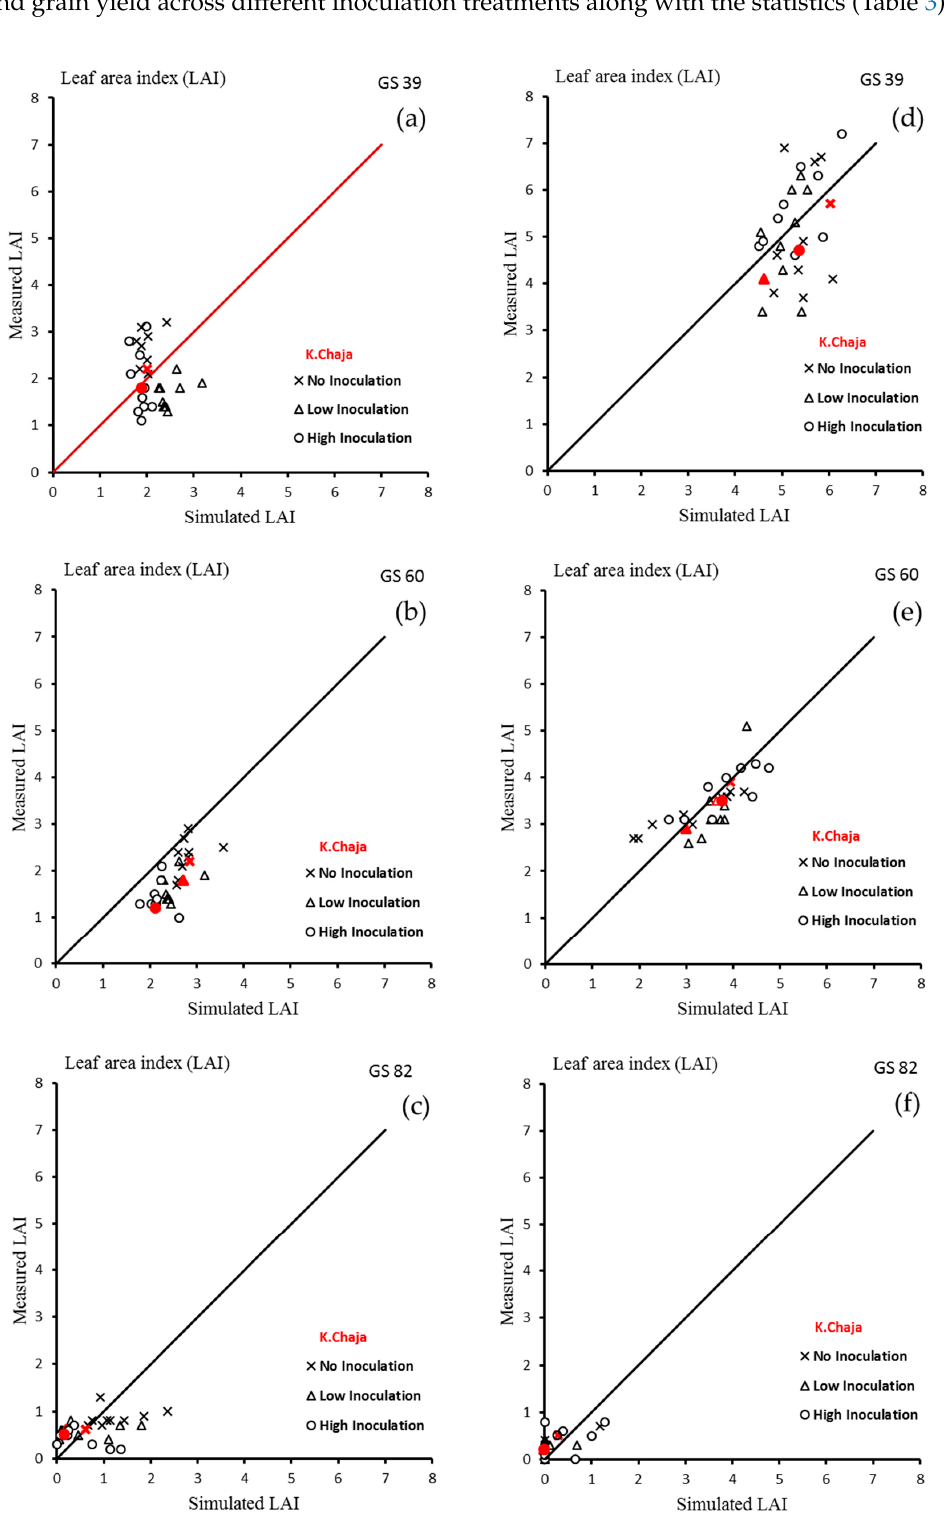
Figure 2. Simulated vs. measured leaf area index (LAI) for calibration (year 2010 a – c ) and validation (year 2011 d – f ) for all ten cultivars on the location La Plata. Different symbols represent the different inoculation treatments where × = No Inoculation; ∆ = Low Inoculation and O = High Inoculation.